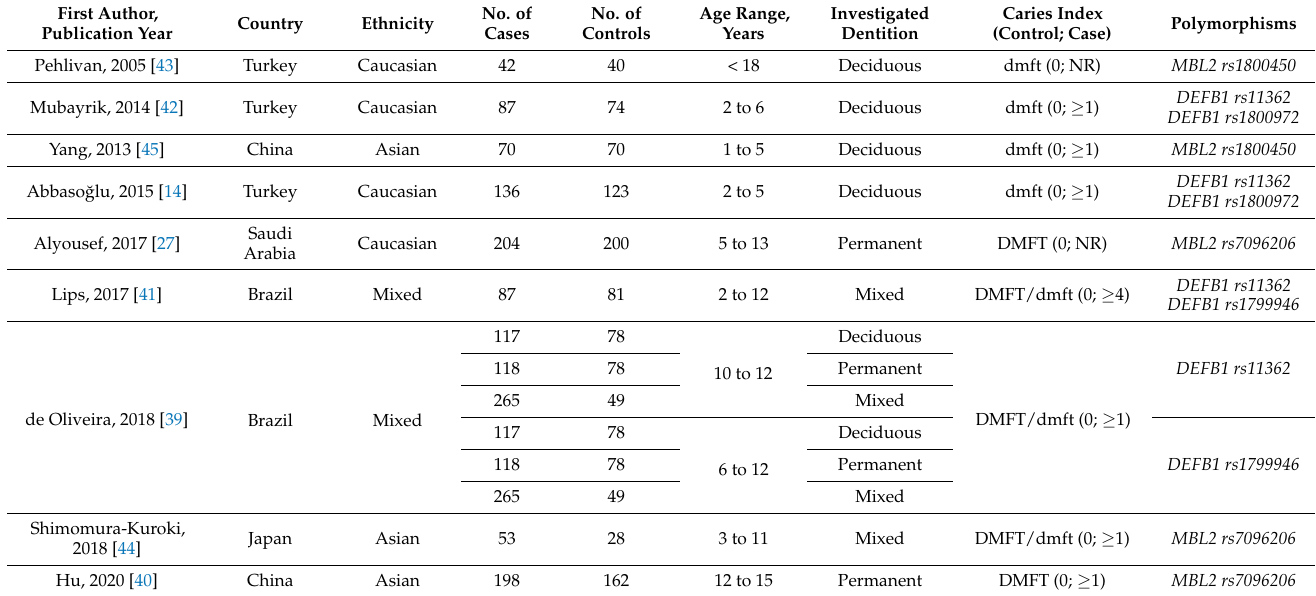
Table 1. Features of articles included in the analysis.